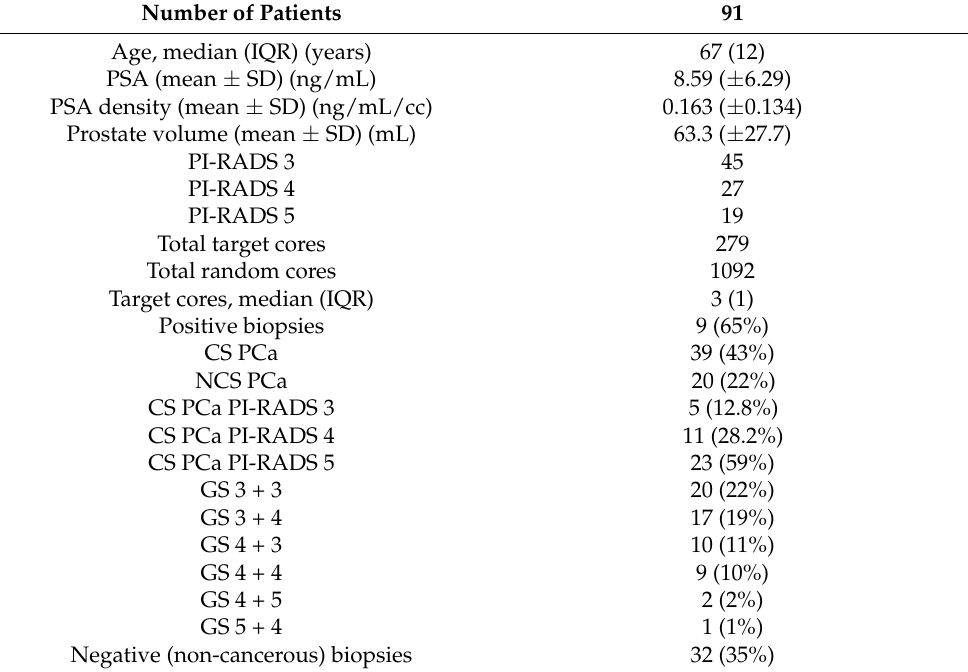
Table 1. Patients’